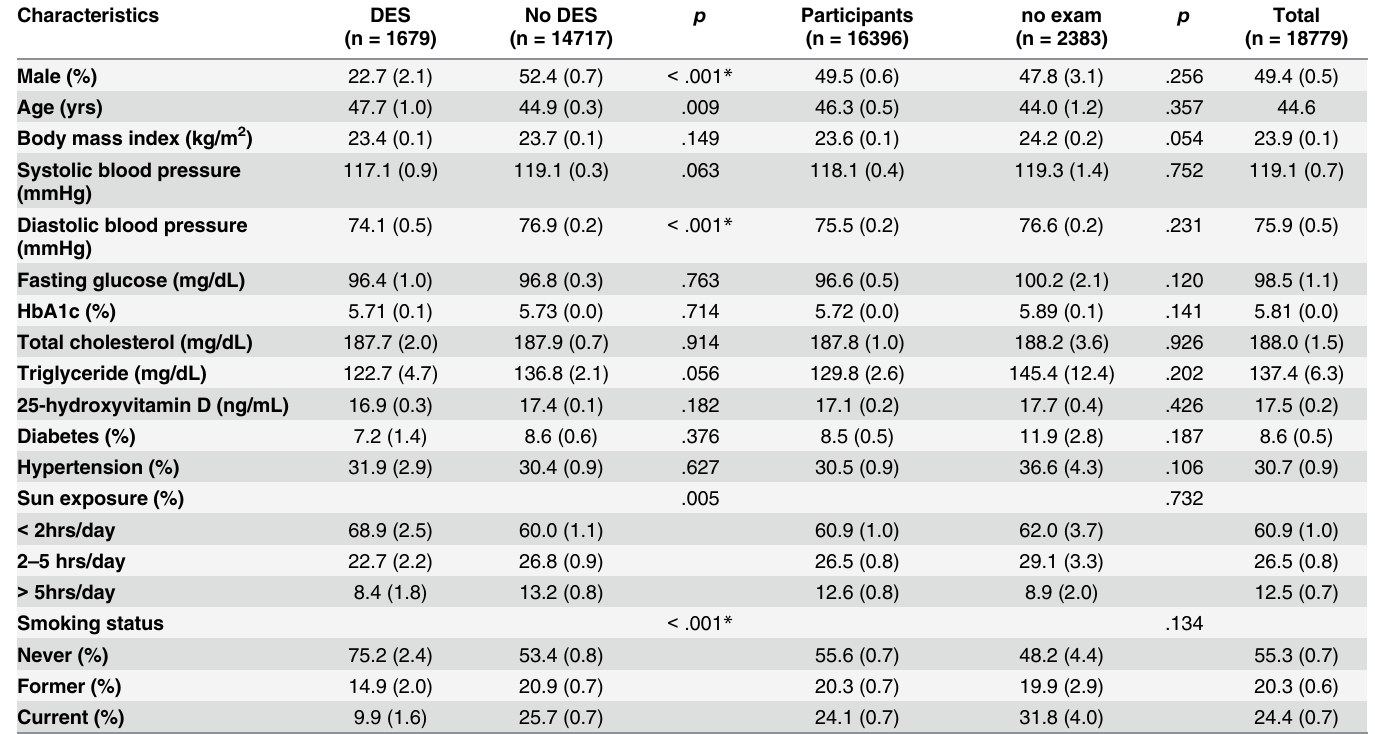
Table 1. Demographic and clinical characteristics, according to dry eye syndrome (DES) status, as reported in the Korean National Health and Nutrition Examination Survey 2010 – 2012.